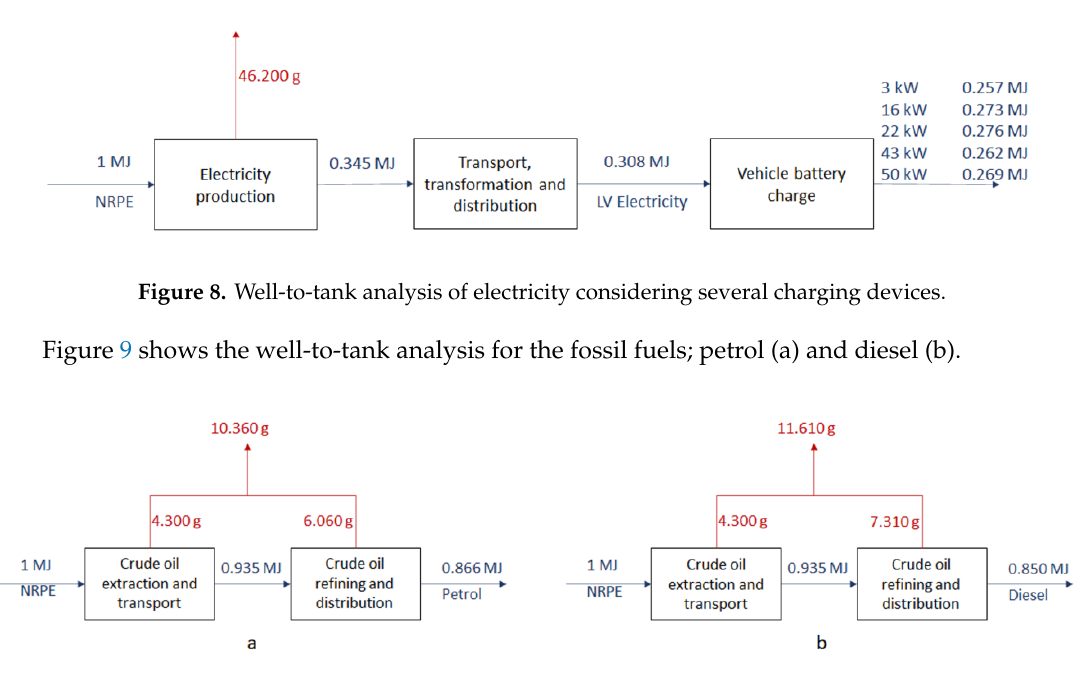
Figure 9. Well-to-tank analysis of fossil fuels, petrol ( a ) and diesel ( b ).